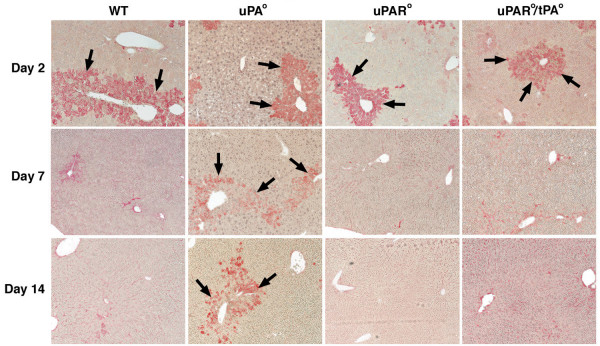
Receptor-free uPA is required for fibrin clearance. Detection of fibrin deposition by immunohistochemistry (red stain, arrows) shows uniform staining in centrilobular area in livers of mice of all genotypes 2 days after CCl4. The clearance of fibrin coincides with the resolution of the centrilobular injury by day 14 in mice of each genotype, except for uPA° mice. (Magnification 200×)